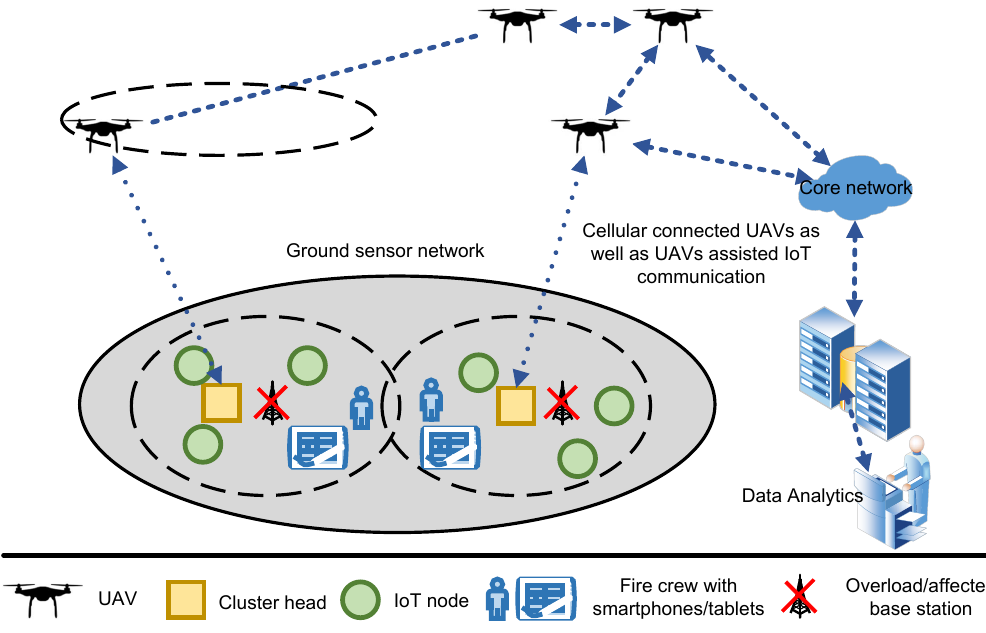
Figure 2. Overview of UAV-enabled IoT platform for disaster